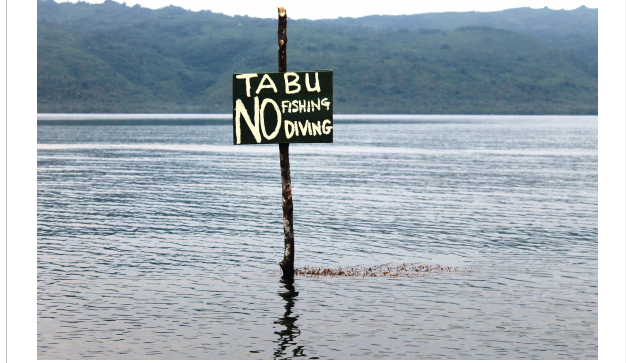
FIGURE 4 Signpost in Malaita province, Solomon Islands, marking a ‘ Tabu ’ area in which fi shing is prohibited. This traditional practice is rooted in sustainable resource management. Photo courtesy of Jan van der